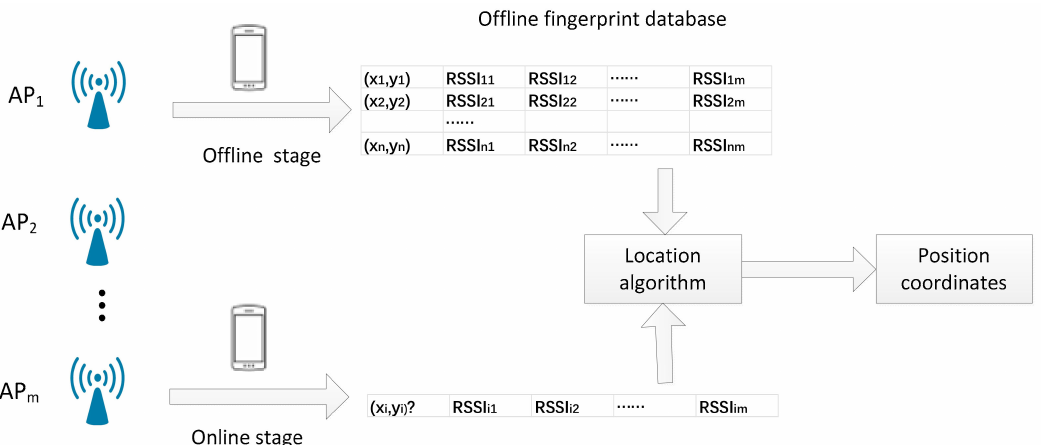
Figure 2. Location principle of fingerprint positioning. (The offline fingerprint database is established by collecting the wireless signal strength of the reference points in the offline stage. The positioning algorithm is the research method in this paper, and the position coordinates are the coordinates of unknown